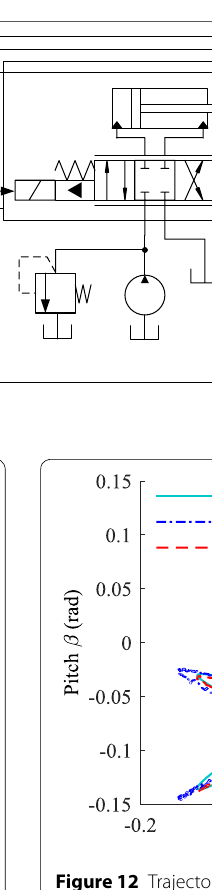
Figure 10 Trajectory tracking in roll freedom